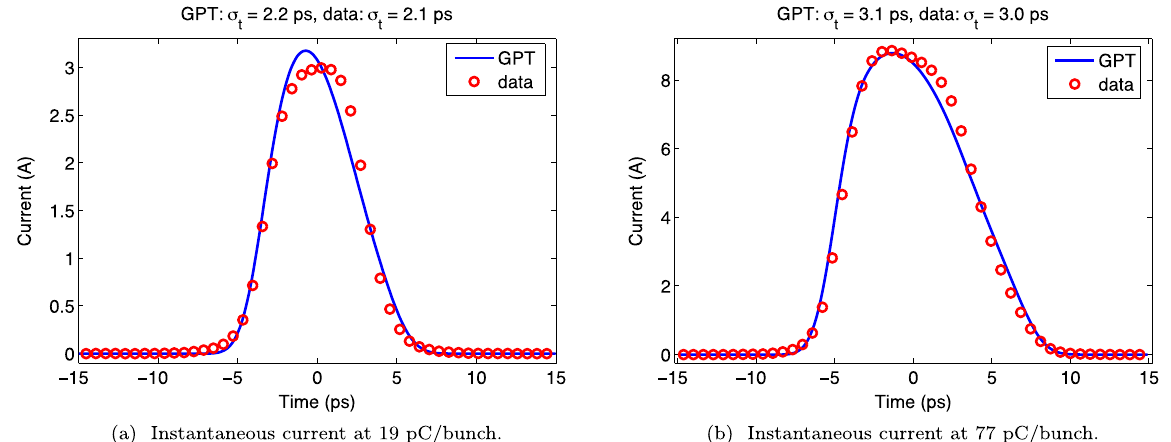
.FIG. 16. Comparison of the measured beam current to GPT simulation. The estimated uncertainty in the rms bunch lengths was (a) (cid:1) 0 : 1 ps and (b) (cid:1) 0 : 2 ps